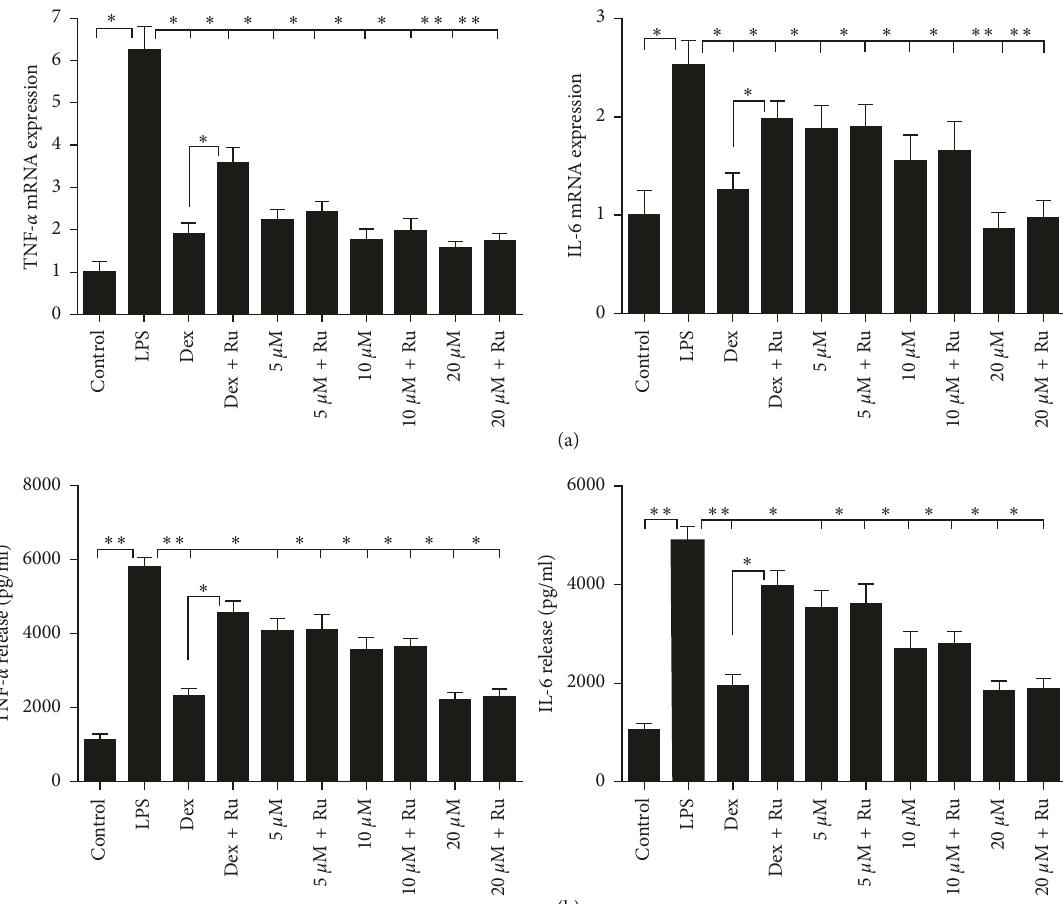
Figure 4: Effects of GR antagonist on the inhibition of TNF- α and IL-6 by physalin B. RAW264.7 cells were treated with different concentrations of physalin B (5, 10, and 20 μ M) or Dex (1 μ M) for 2h with/without 1h pretreatment of RU486 (10 µ M) and then stimulated with 1 µ g/ml LPS for 8 h. (a, b) Total cellular RNA was extracted and reverse transcribed. The relative mRNA levels of TNF- α and IL-6 were detected by real-time PCR as described in Materials and Methods. GAPDH was used as a loading control. (c, d) The TNF- α and IL-6 protein levels were detected by ELISA. Each value indicated the mean SEM and was representative of results obtained from three independent ±